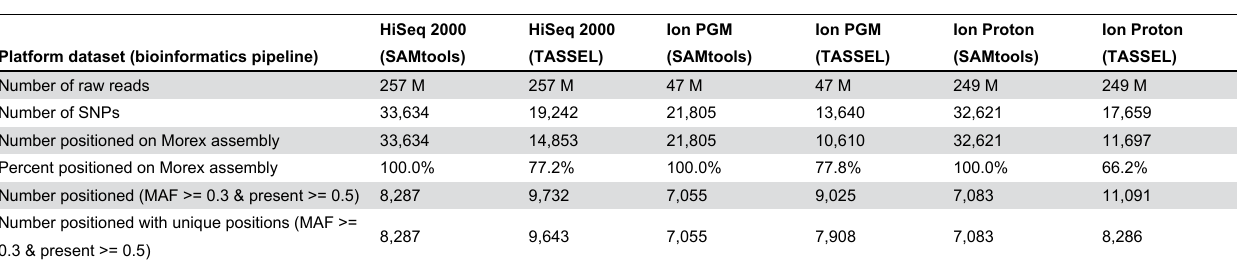
Table 1. The number of SNPs positioned on the Morex reference assembly for Morex x Barke recombinant inbred lines using genotyping-by-sequencing on three different sequencing platforms; HiSeq 2000, Ion Torrent PGM and Ion Torrent